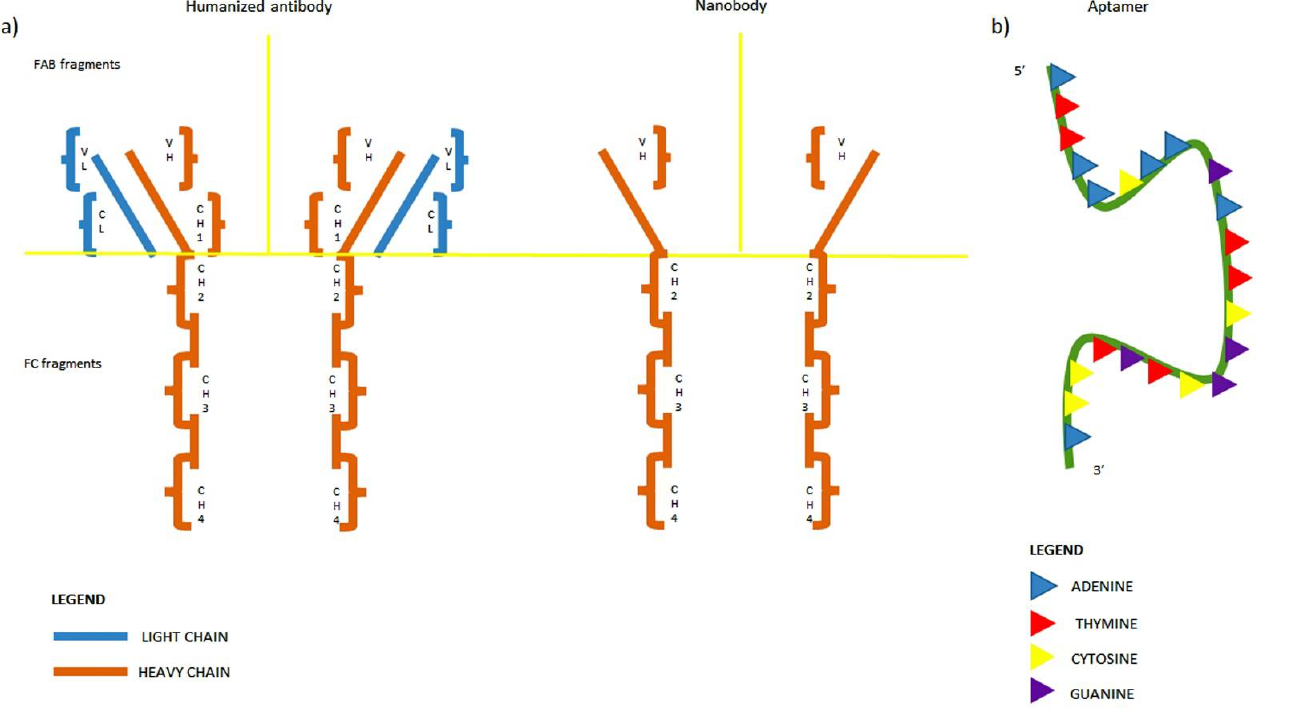
Figure 2. ( a ) Comparison of antibody and nanobody structure . In both cases, the yellow line separates the FAB fragments from the FC fragment. CH: constant heavy chain domain; VH: variable heavy chain domain; CL: constant heavy chain domain; VL: variable heavy chain domain. ( b ) Aptamer structure: single-stranded oligonucleotide with complementary sequence to the target.